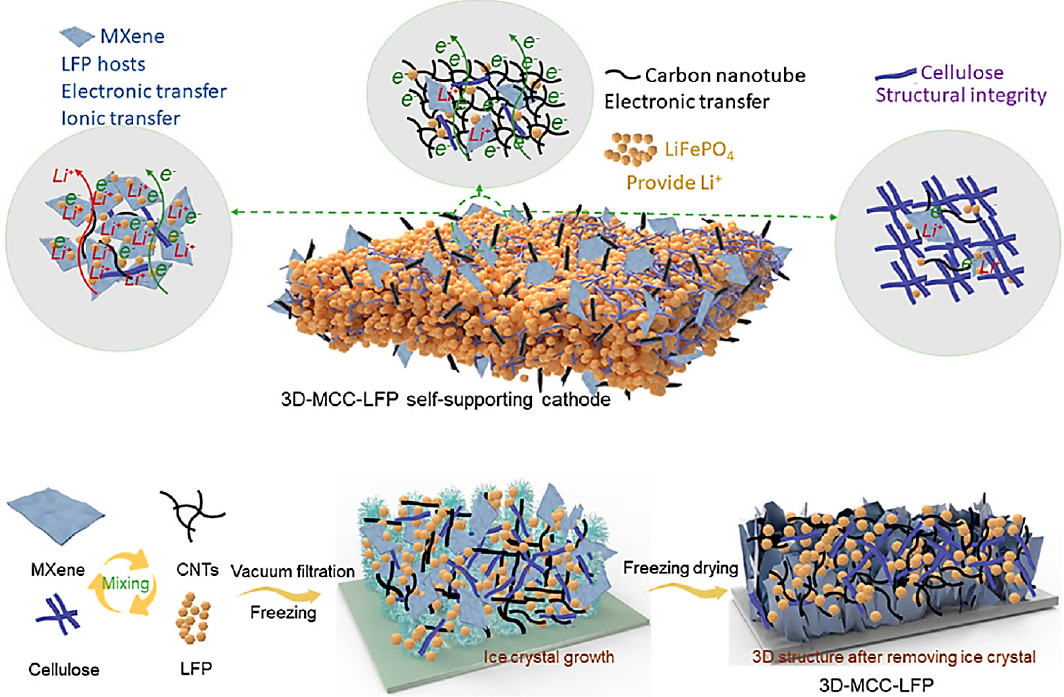
Figure 9. The preparative process of 3D MXene (Ti 3 C 2 T x )-CNT-cellulose-LiFePO 4 (3D-MCC-LFP) cathodes. Adapted from Ref [37] with permission. Copyright 2022 Elsevier.